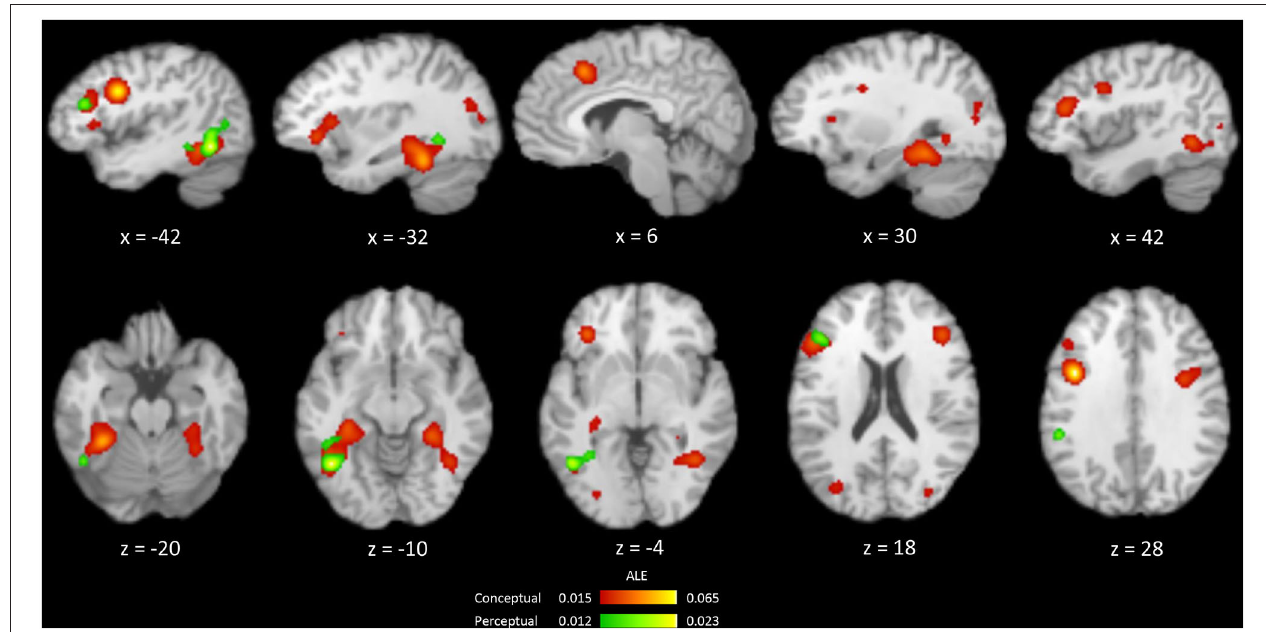
FIGURE 3 | Brain regions showing the occurrences of repetition suppression from an ALE meta-analysis of the conceptual (red) and perceptual (green) priming experiments.